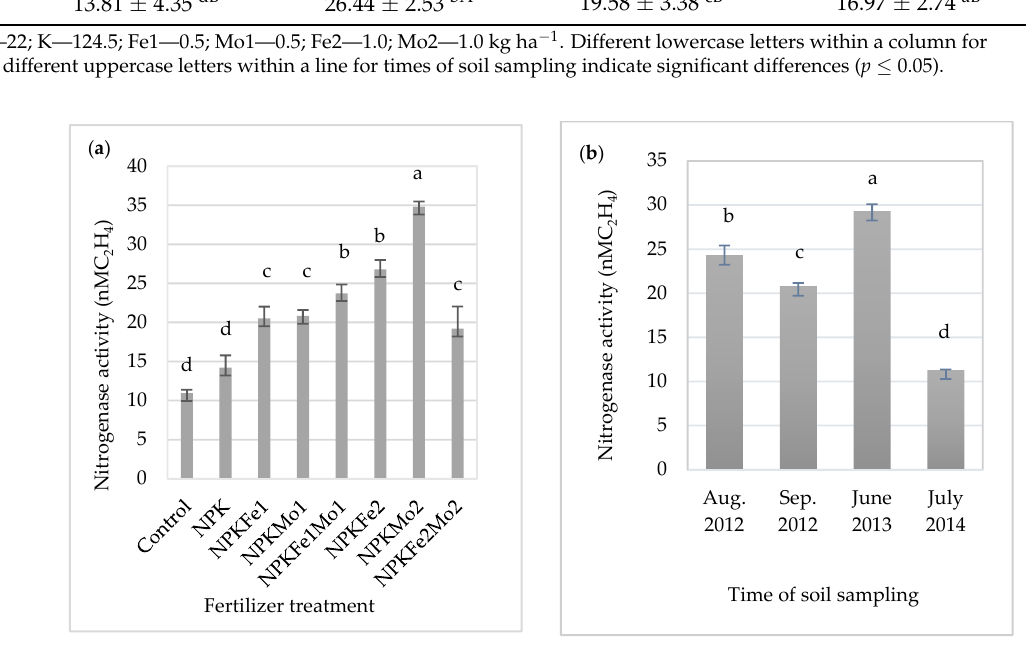
Fertilizer Treatment